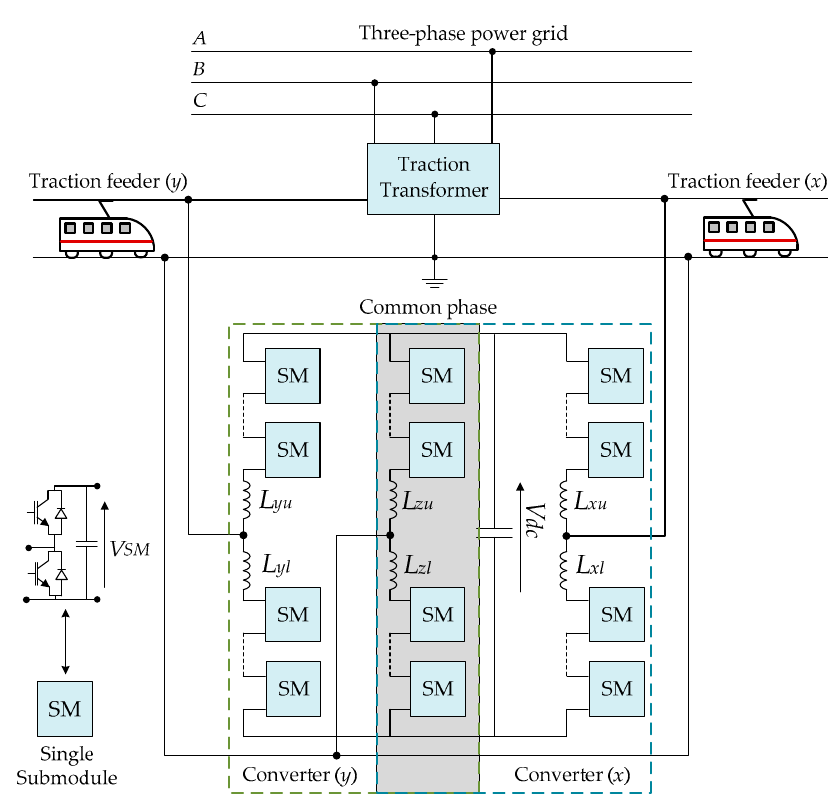
Figure 14. RPC based on two-phase three-wire indirect modular multilevel converter (HB-MMC3 RPC) (based on [58]). Table 11. Components quantities of the HB-MMC3 RPC.